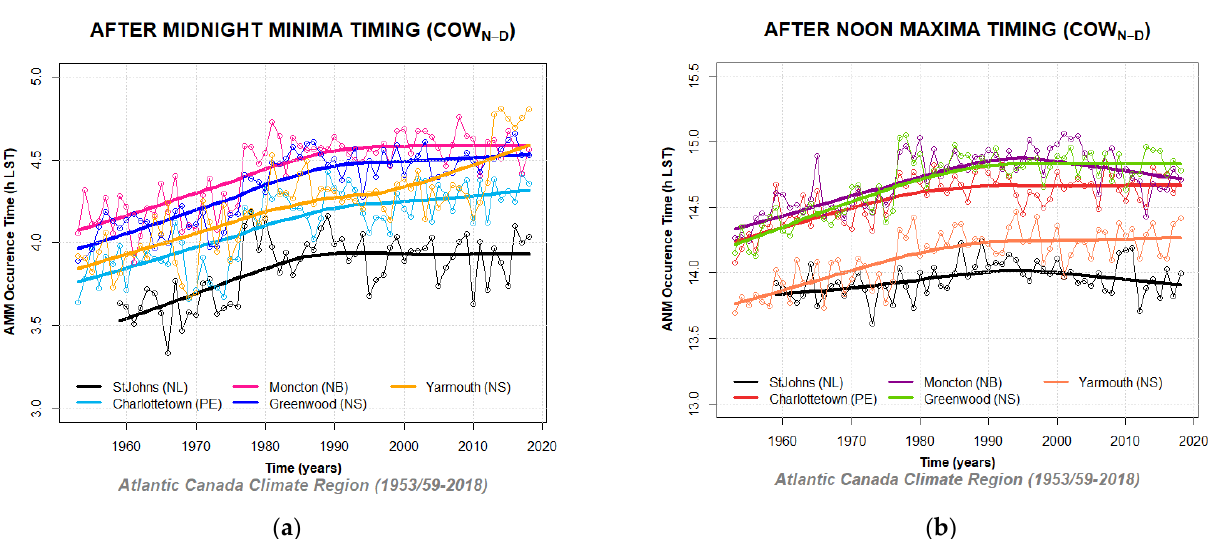
Figure A27. Annually averaged After Midnight Minima ( a ) and After Noon Maxima timing shifts ( b ) and LOESS fit curves for St. John’s (NL), Charlottetown (PE), Moncton (NB), Greenwood (NS), and Yarmouth (NS) temperature time series, Atlantic Canada climate region.